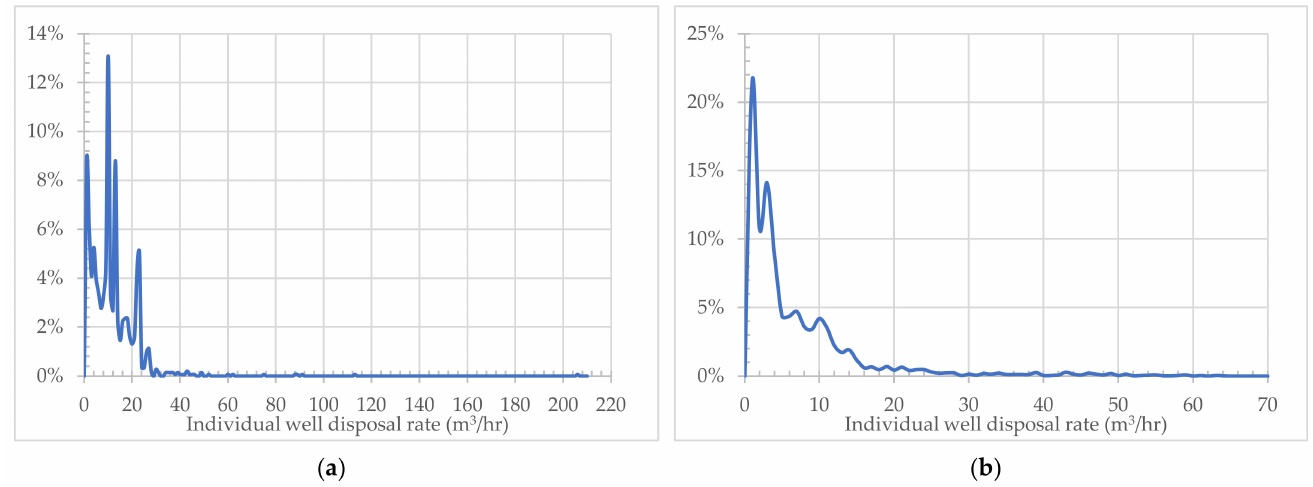
Figure A3. Historical per-well water injection rate ( X -axis) frequency ( Y -axis) distributions (January 1962–December 2022) in ( a ) the Paddy Formation; ( b ) the Cadotte